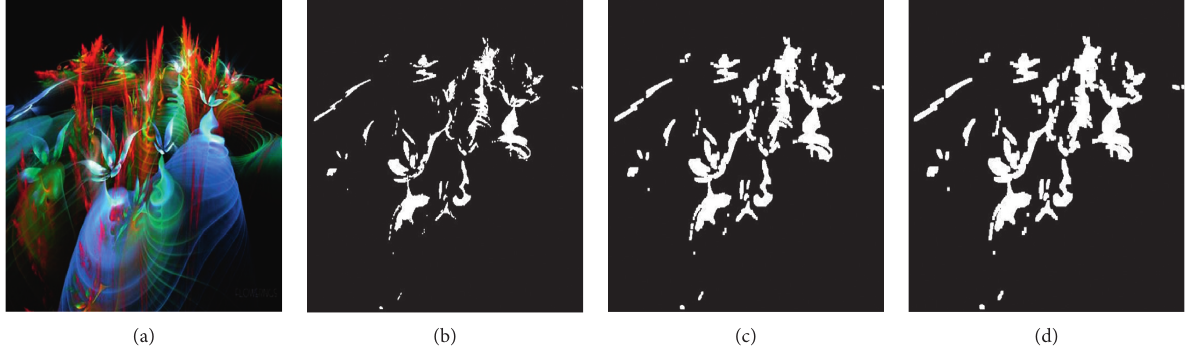
Figure 7: The Newton iteration graph after the expansion operation of the diamond structure element in different units. (a) Original image. (b) 1-unit diamond structural element expansion. (c) 2-unit diamond structural element expansion. (d) 3-unit diamond structural element